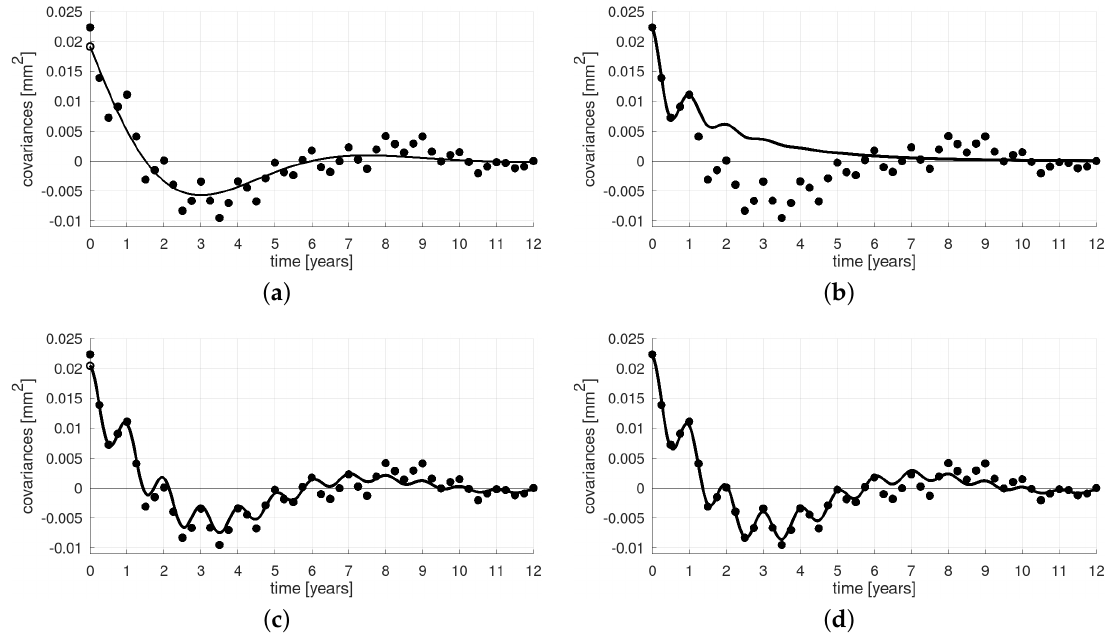
Figure 2. Covariance functions for the Milan Cathedral data sets determined with four different approaches: ( a ) Intuitive ("naive") approach using a single SOGM-process with manually adjusted parameters. ( b ) Covariance function resulting from the interpolation of the first p + 1 covariances with a pure AR(4)-processes. ( c ) Covariance function resulting from an approximation procedure of (cid:101) g S S using a pure AR-process with p = 4. ( d ) Covariance function based on approximation with the (cid:101) g 24 most flexible ARMA-process ( p = 4). Empirical covariances are shown by the black dots. The variances S of the covariance functions are indicated by circles. The parameters of the processes ( c ) and ( d ) are (cid:101) g 0 provided in Tables 2 and